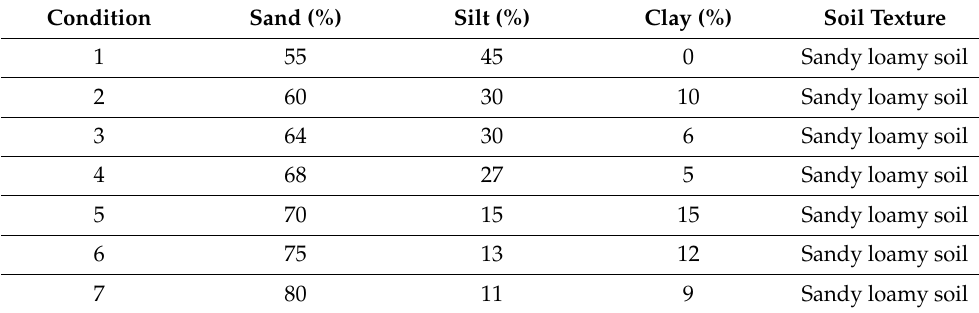
Table 1. Soil parameters requiring finite element analysis.